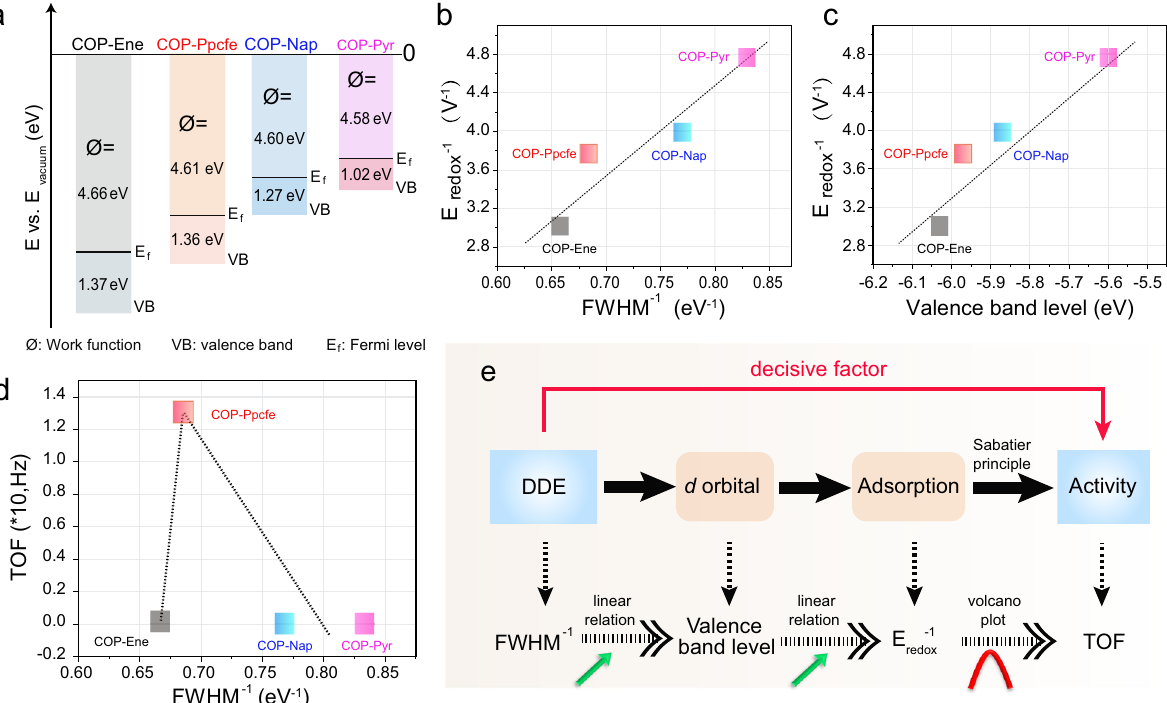
Fig. 4 The relationship between DDE and catalytic activity. a The schematic diagram of the valence band spectra and work function spectra (Ø) for COP- Ene, COP-Ppcfe, COP-Nap, and COP-Pyr samples ( E f is the Fermi level). b The linear relationship of the E redox − 1 vs. FWHM − 1 . c The linear relationship of the E redox − 1 vs. the valence band level. d Volcano plot between catalytic activity (quanti fi ed by TOF) and DDE (quanti fi ed by FWHM − 1 ). e Schematic diagram of the mechanism of DDE affecting catalytic